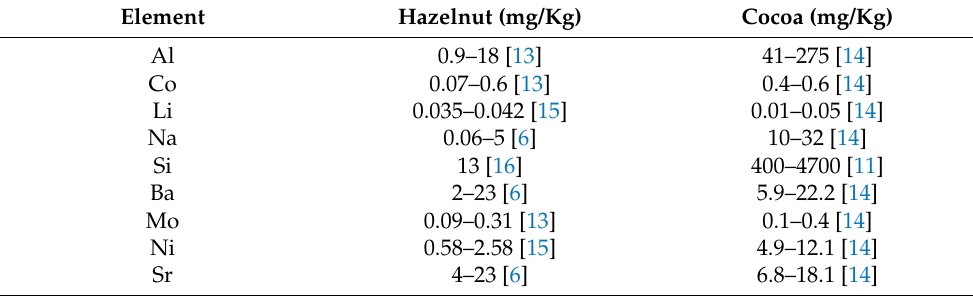
Table 2. Mineral content of hazelnuts and cocoa powder from the literature data.